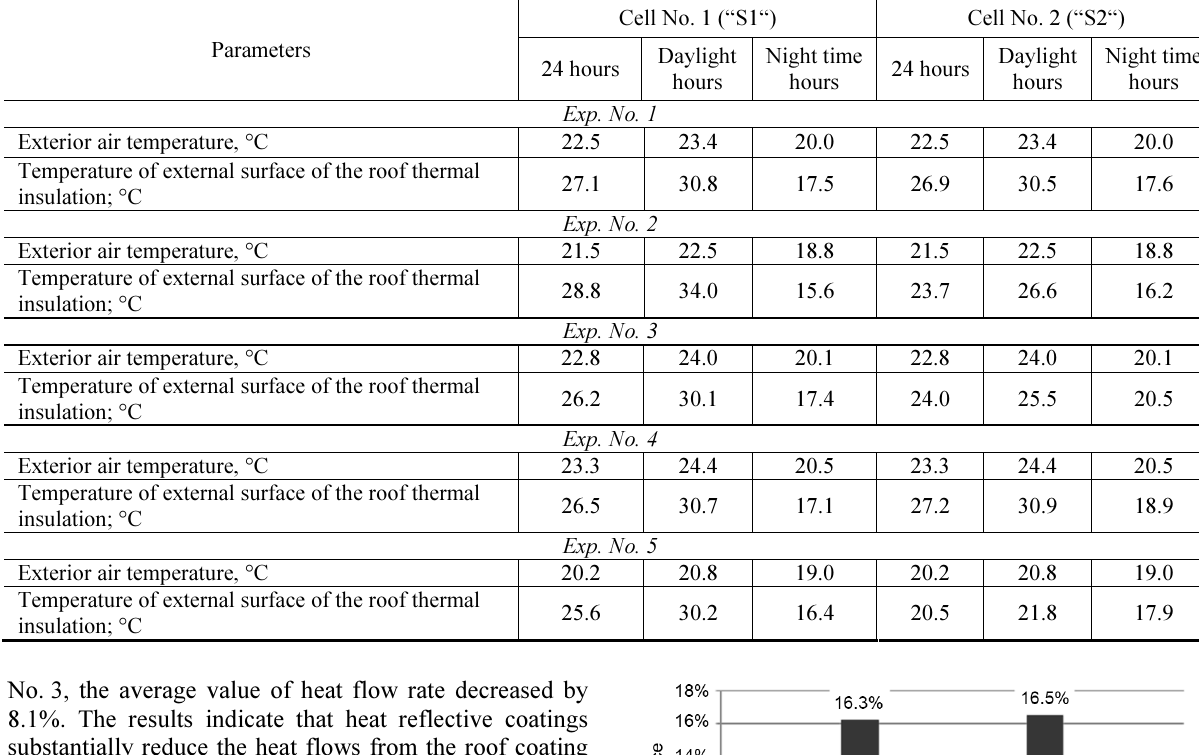
Table 2. Average temperatures of the exterior air and exterior surfaces of the thermal insulation layers of the roof during the day, night and twenty-four hours, measured during the experimental research Cell No. 1 (“S1“) Parameters